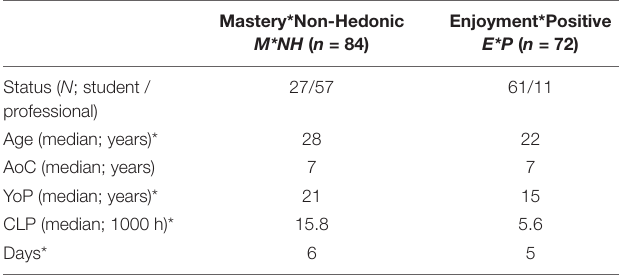
TABLE 6 | Demographic and musical expertise characteristics of subgroup musicians.